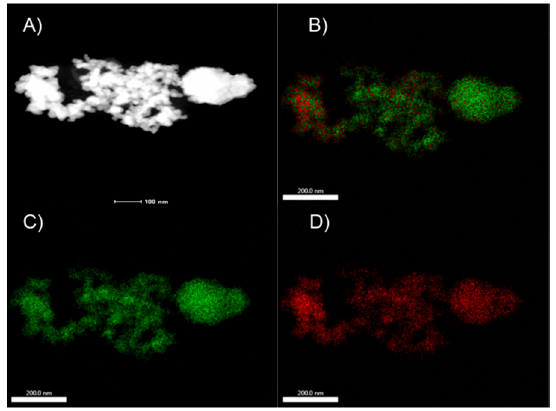
Figure 2. ( A ) STEM images and STEM-EDS mapping images of ( B ) Pd / Cu, ( C ) Pd, and ( D ) Cu of the